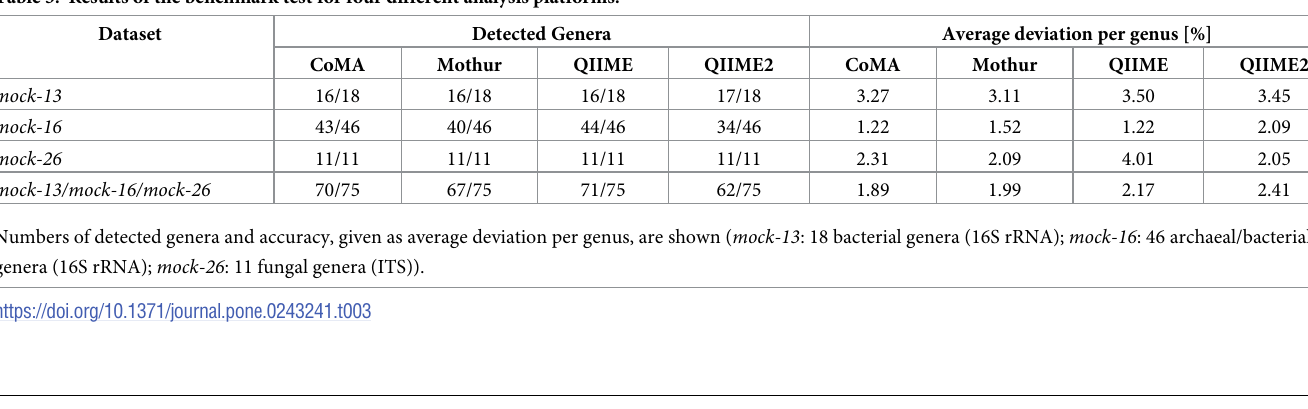
Table 3. Results of the benchmark test for four different analysis platforms.